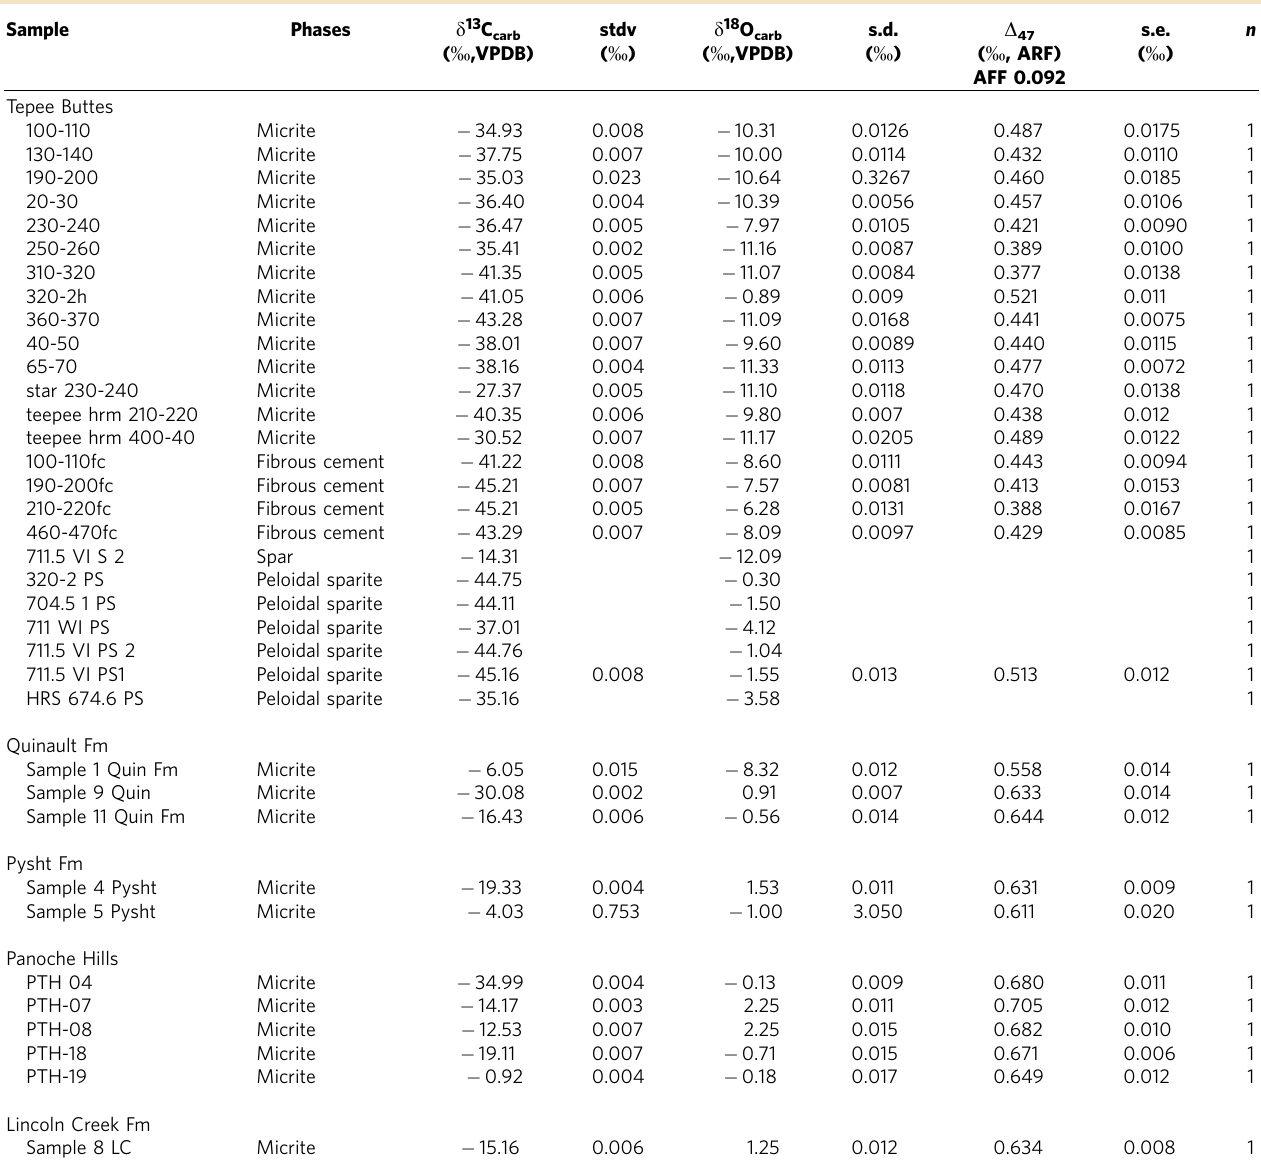
Table 2 | Ancient seep carbonate geochemical data. Sample Phases